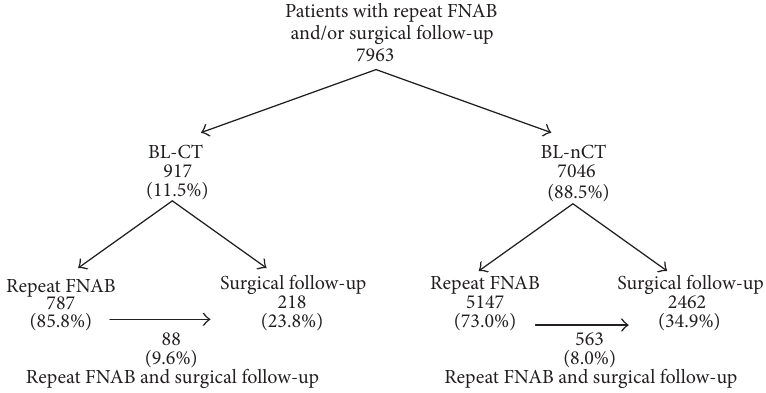
Figure 1: Patients included in the study (BL-CT—patients with benign lesions with features of chronic thyroiditis in first FNAB, BL-nCT— patients with benign lesion without features of chronic thyroiditis in first